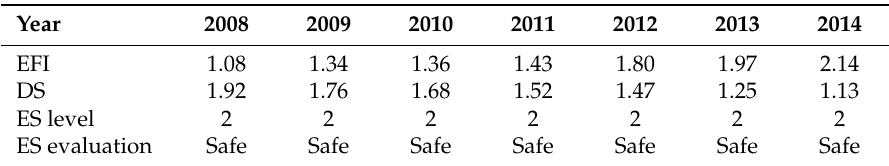
Table 1. Cing-Jing region 2008–2014 ecological pressure index (EFI), ecological quotiety (DS), and eco-security (ES).